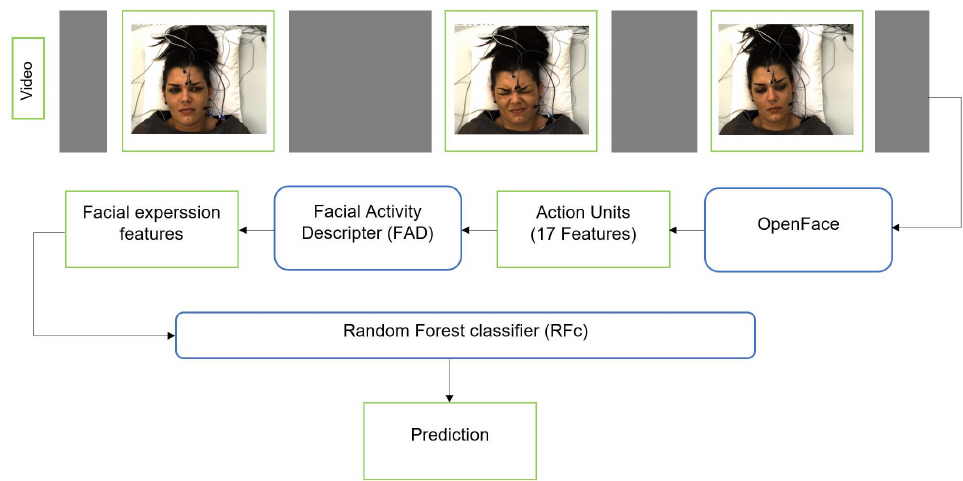
Figure 3. The pipeline of pain classification using RFc with FAD.